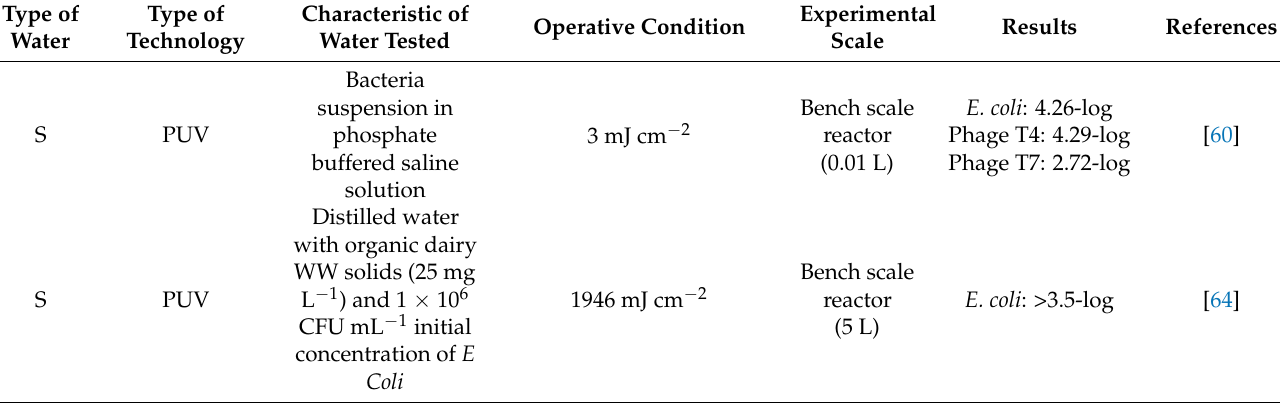
Table 2. Several results of PUV and UV-LED disinfection tests. S: synthetic water, R: real water. Type